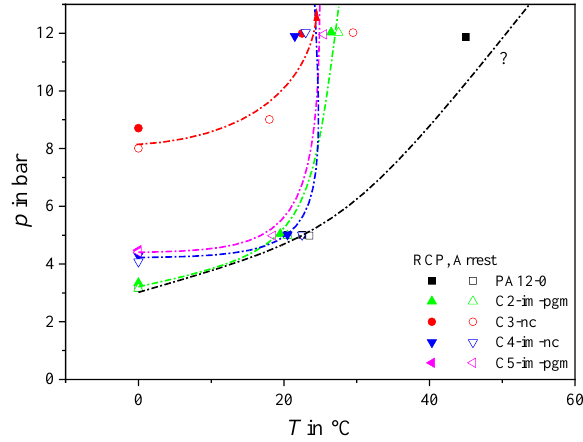
Figure 3. RCP characteristics of various PA12 grades measured via S4 tests.